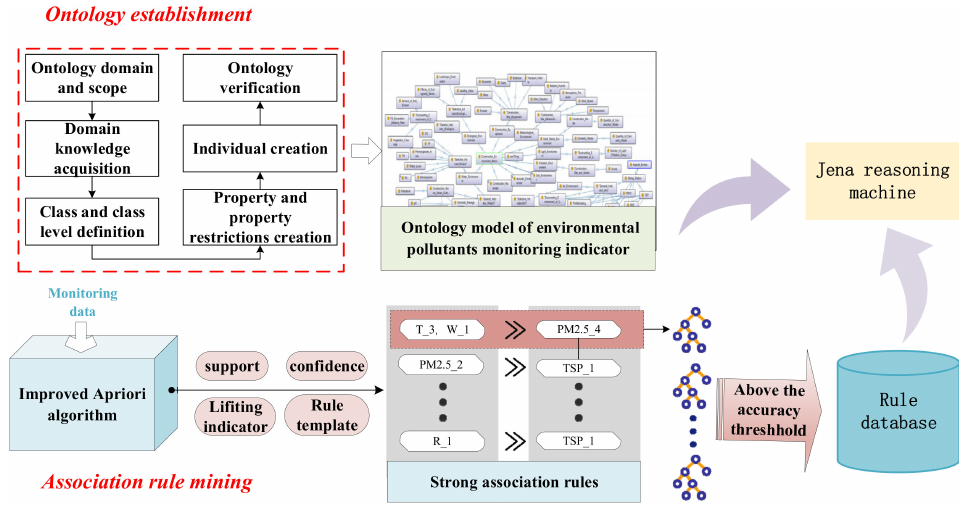
Figure 1. The methodology of this